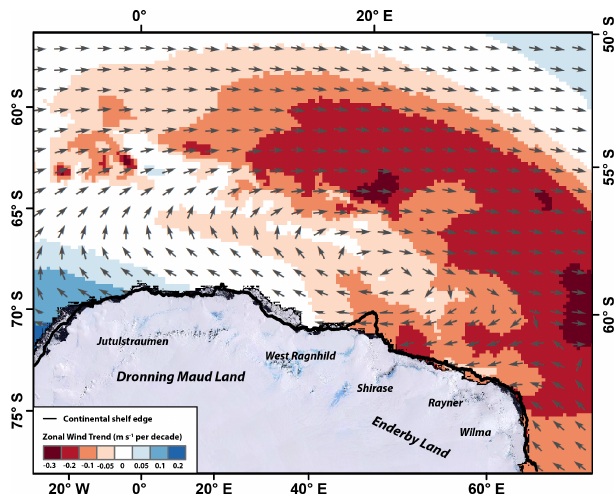
Figure 4. Linear zonal wind trend for 1979–2021 with data smoothed with a 60-month moving average prior to extracting the trend. Negative values indicate a trend for zonal winds in a more easterly direction and positive values indicate a trend for winds in a more westerly direction. Mean wind direction (1979–2021) is repre- sented by the grey arrows. Major outlet glaciers have been